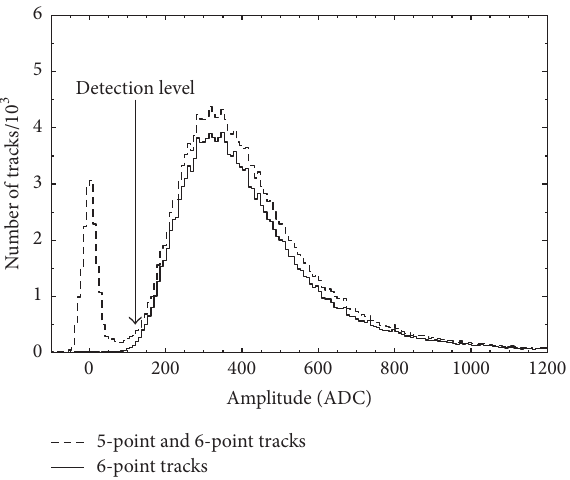
Figure 6: Signal timing curves: the tracking efficiency of the two inner layers as a function of the delay relative to the arrival of the coincident trigger (mostly from the four other detector layers, operated using high efficiency settings, see text). The measurement is consistent with the observed signal peaking time of 2 𝜇 s, the value used as the “standard” delay setting.